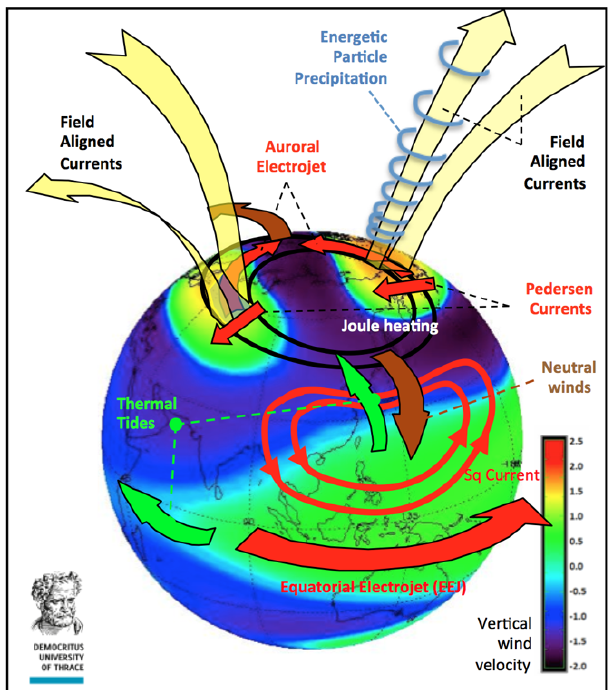
Figure 1. Overview of the main processes affecting momentum and energy transport and distribution in the